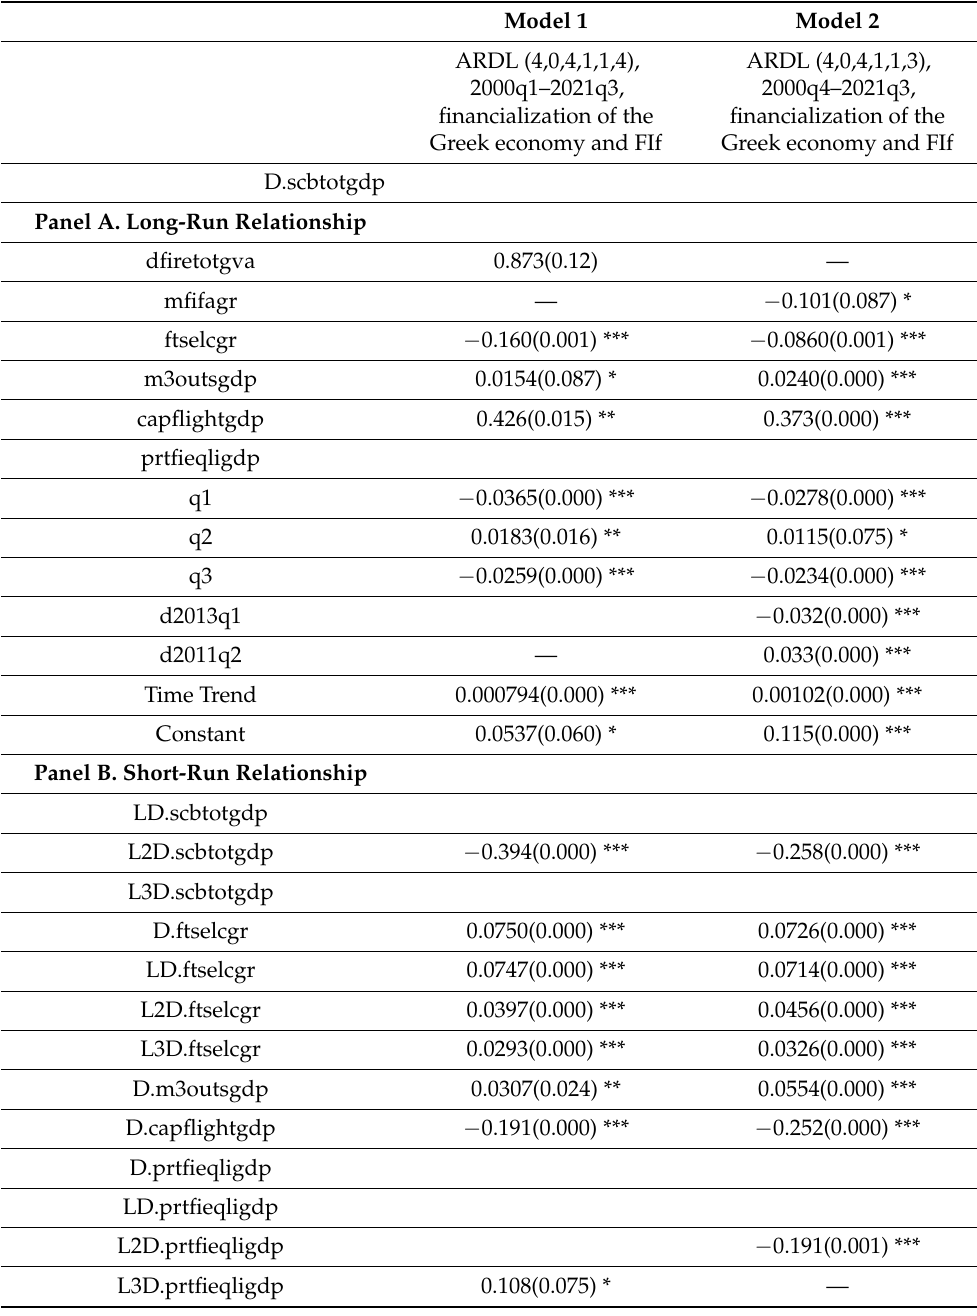
Table 3. Autoregressive distributed lag (ARDL)